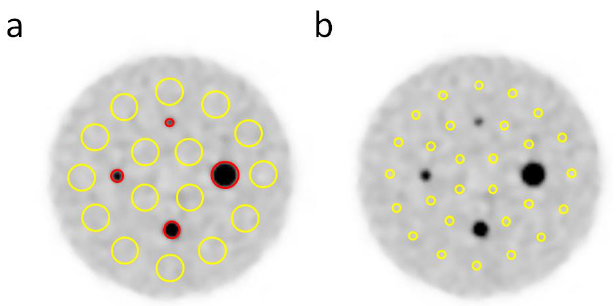
Figure 3. Positioning of the volumes of interest (VOIs) for the analyses of image quality. VOIs measuring 10 mm ( a ) and 3 mm ( b ) in diameter were placed on the phantom background ( yellow ) of the reconstructed images at a sphere-to-background radioactivity ratio of 8:1 and were used for the analysis of the coefficient of variation of the background (CV BG ), the contrast recovery coefficient (CRC), and the detectability index (DI). In addition, VOIs of the same diameter as each sphere were placed over the hot spheres for the determination of the CRC (a; red ).